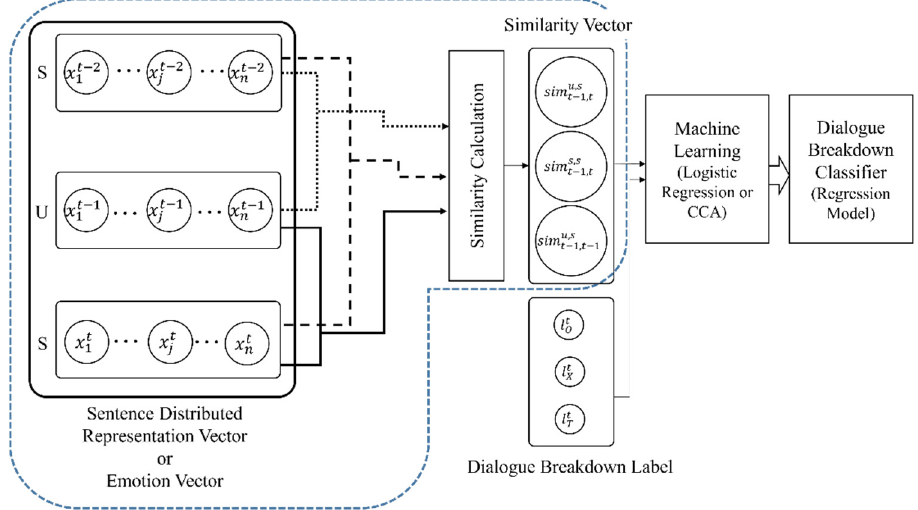
Figure 4. Creation flow of dialogue breakdown regression model.